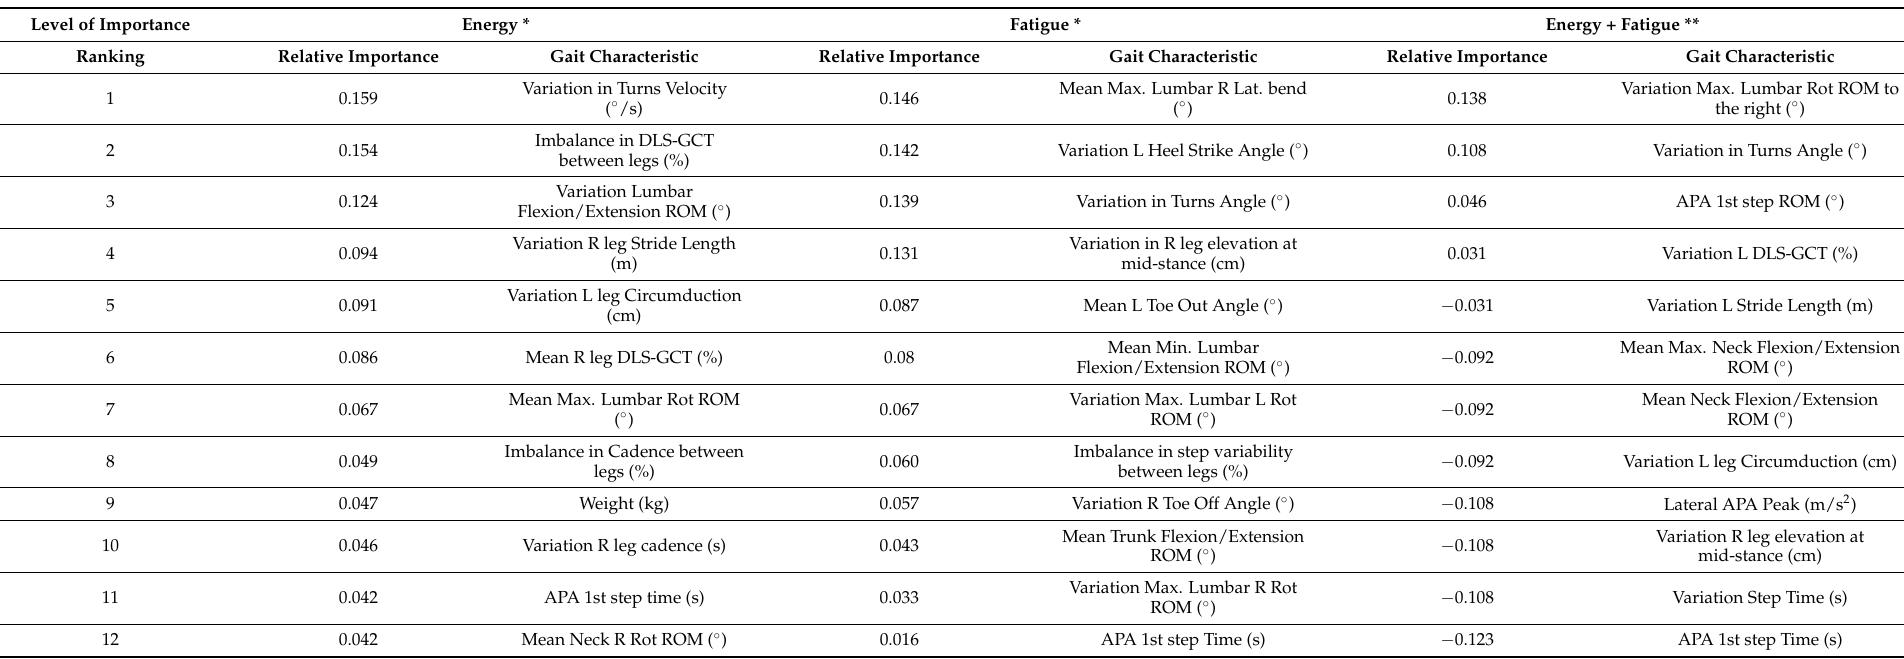
Table 2. Top 12 most important features for best classifier